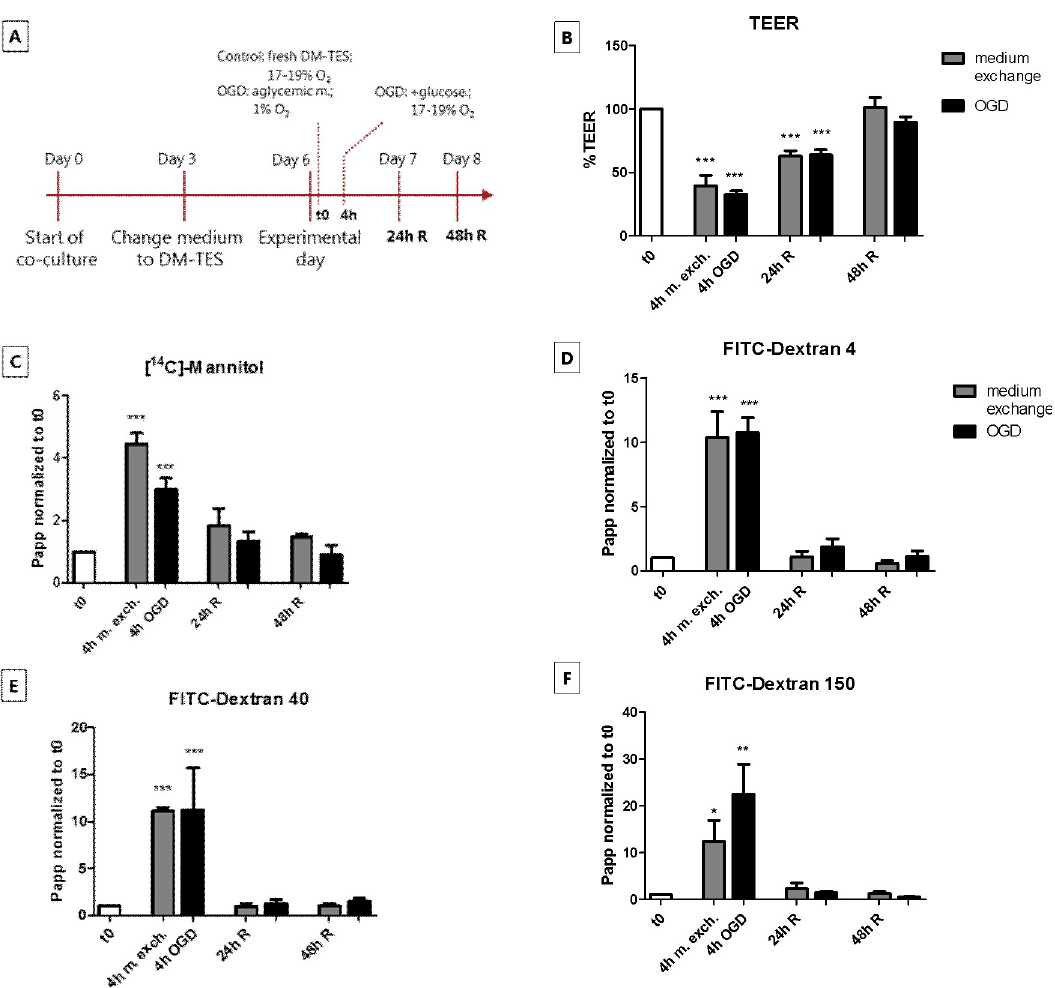
Fig 1. Transendothelial electrical resistance (TEER) and permeability of paracellular flux markers across brain endothelial cell monolayers in co-culture, during in vitro oxygen-glucose deprivation (OGD) and medium exchange treatments. (A) Schematic overview of OGD and medium exchange protocols. At day 0, the endothelial cells were seeded on filter inserts in contact co-culture with astrocytes. At day 3 of co-culture, the cell medium (GM-) was changed to DM-TES medium. After additional 3 days (day 6), when the monolayers had developed an optimal resistance, the cells were exposed to OGD or subjected to simple medium exchange as control. After 4 h, standard culture conditions were reestablished for the OGD treated cells, in order to mimic the reperfusion phase (R). The cells were checked after 24 and 48 h of reperfusion. (B) TEER and (C-F) paracellular permeability of [ 14 C]-mannitol, FITC-dextran 4, FITC-dextran 40 and FITC-dextran 150 across endothelial monolayers were monitored immediately before OGD/ medium exchange (t0), after 4 h of OGD/medium exchange (4h OGD/m. exch.) and after 24 h and 48 h of reperfusion (24/48 h R). Bar graphs represent means normalized to t0 and error bars are +SEM. N = 12–24, n = 11–12 (B); N = 3–4, n = 3–4 (C-F). The white bars show the values at t0, the gray bars show the cells subjected to medium exchange only, while the black bars represent the cells treated with OGD. Columns were compared to t0 using one-way ANOVA and Dunnett’s multiple comparison post-test. � : p < 0.05, �� : p < 0.01, ��� : p < 0.001. Each pair of columns was compared using one-way ANOVA with Bonferroni’s post-test. TEER had a mean value of 1118 ± 112 O � cm 2 (n = 14). The resistance decreased significantly after both 4 h of OGD (362 ± 43 O � cm 2 ) and medium exchange (349 ± 76 O � cm 2 ), as compared to the TEER at time zero (t0). After 24 h of reperfusion, the TEER increased to 691 ± 67 O � cm 2 in the cell treated with OGD and to 581 ± 57 O � cm 2 in the cells subjected to medium exchange, and after 48 h of reperfusion it returned to the initial levels in both experimental set up (928 ± 89 O � cm 2 in the OGD-treated cells and 929 ± 92 O � cm 2 in the cells that had undergone medium exchange). The passive permeability of the markers [ 14 C]-mannitol (180 Da), FITC-